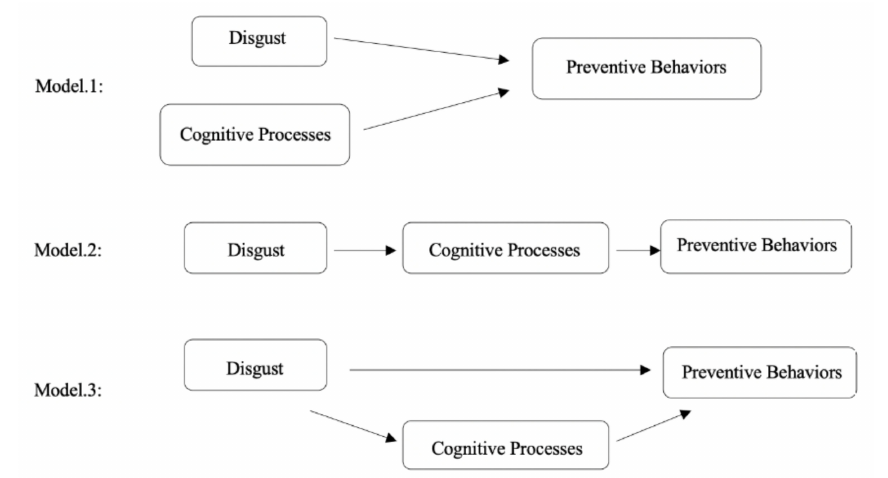
Figure 1. Hypothesized models of preventive behaviors.